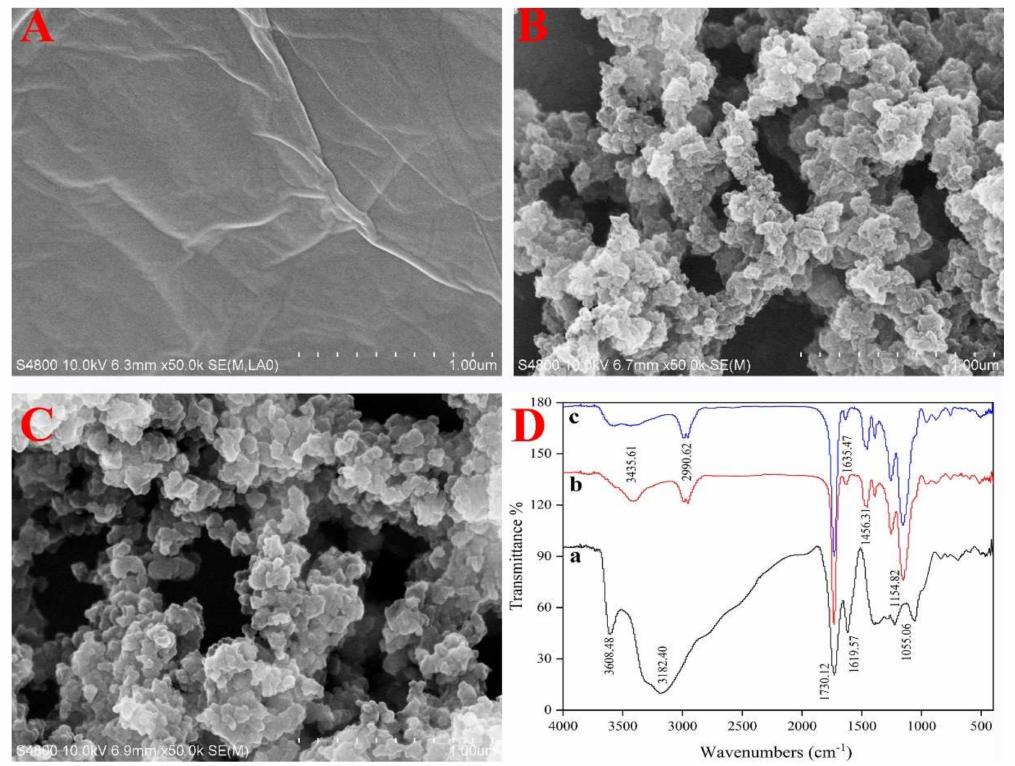
Figure 1. SEM images and FT − IR spectra of the polymers ( A ,a), GO; ( B ,b), GO/NIPs; ( C ,c), GO/MIPs; ( D ), FT-IR